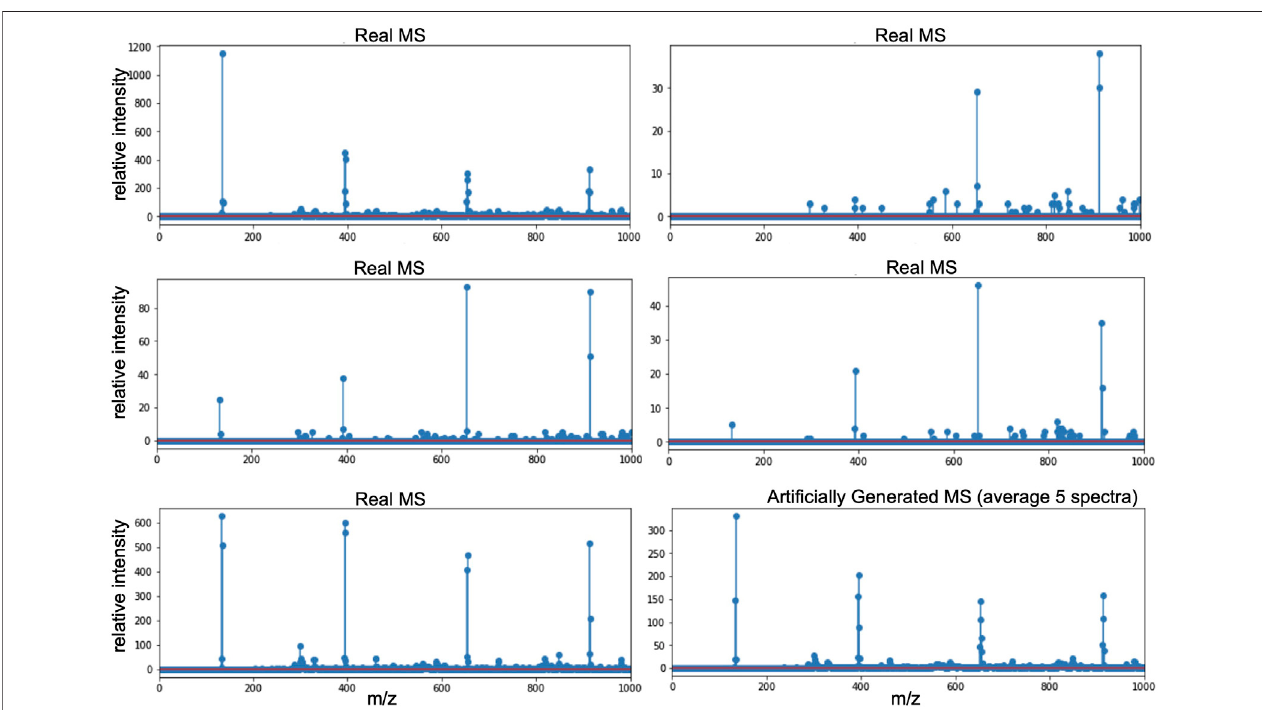
FIGURE 6 | Arti fi cial mass spectrum (bottom right) created averaging fi ve real mass spectra of the calibration sample CsI (cesium iodide sample). The fi ve selected mass spectra were chosen from the same run of experiments in order to have the same instrument ’ s parameters and sample ’ s conditions.